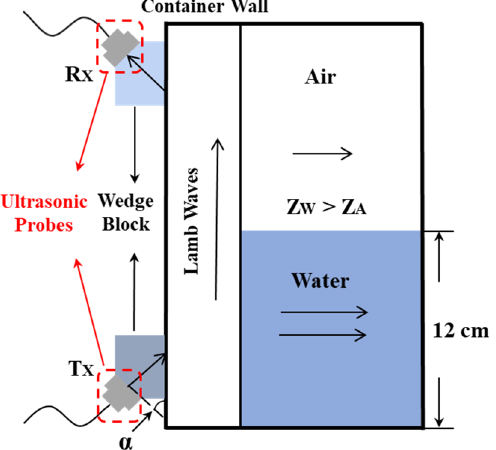
Figure 2. Schematic diagram of liquid-level measurement with ultrasonic Lamb waves. R x = receiver transducer; T x = transmitter transducer; α = ultrasonic incidence angle; Z W = water acoustic impedance; Z A = air acoustic impedance.